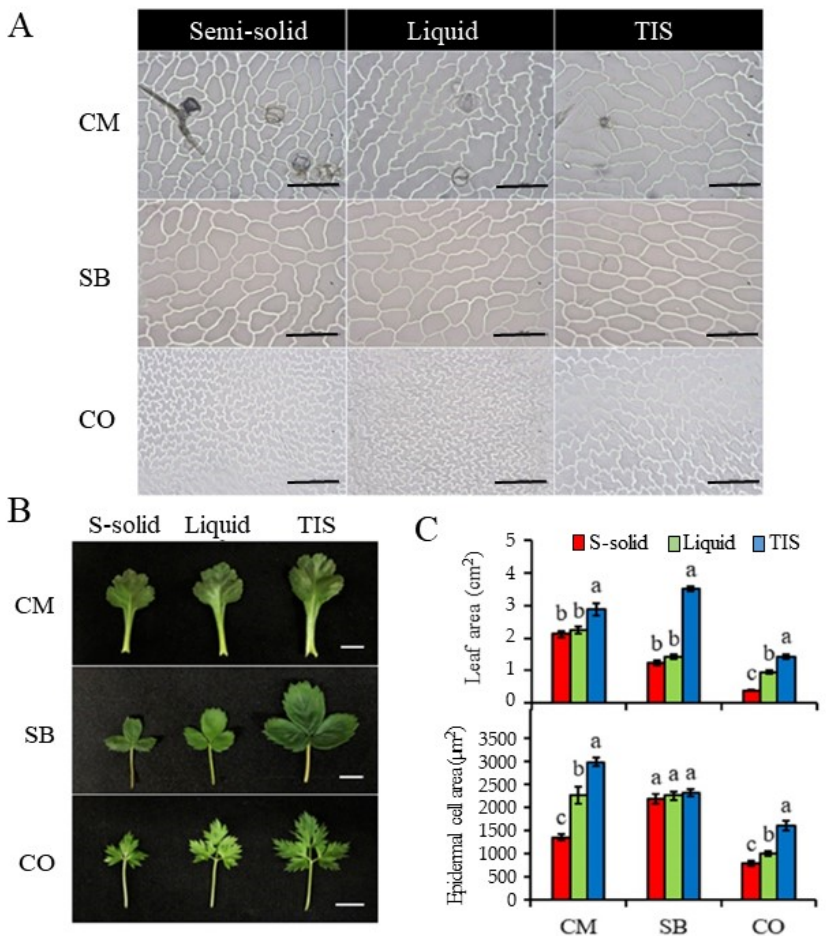
Figure 4. Cytological analysis of chrysanthemum (CM); strawberry (SB); and Cnidium officinale (CO) plants grown in semi-solid, liquid, and TIS cultures. ( A ) Cytological observation of adaxial leaf surface of CM, SB, and CO plants grown in semi-solid, liquid, and TIS cultures (scale bar = 100 µ m). ( B ) Morphological observation of leaves of CM, SB, and CO plants grown in different culture systems (scale bar = 1 cm). ( C ) Leaf area and epidermal cell area of CM, SB, and CO plants grown in semi-solid (S-solid), liquid, and TIS cultures. Bars with different letters differ significantly from each other by Duncan’s multiple-range test (DMRT; p ≤ 0.05).